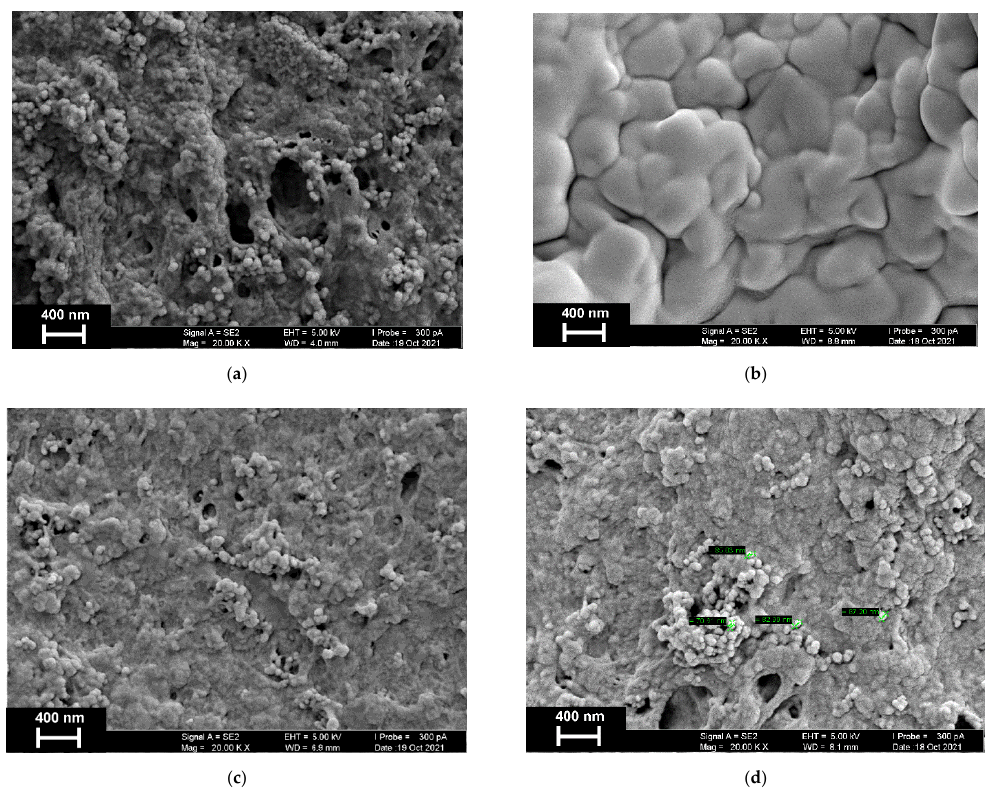
Figure 5. SEM images of the GCE covered with CB in chitosan film ( a ) and coated with TC (50 μ M, 5 μ L) ( b ), TC and DNA 0.1 mg/mL ( c ), TC and DNA 1.5 mg/mL ( d ).